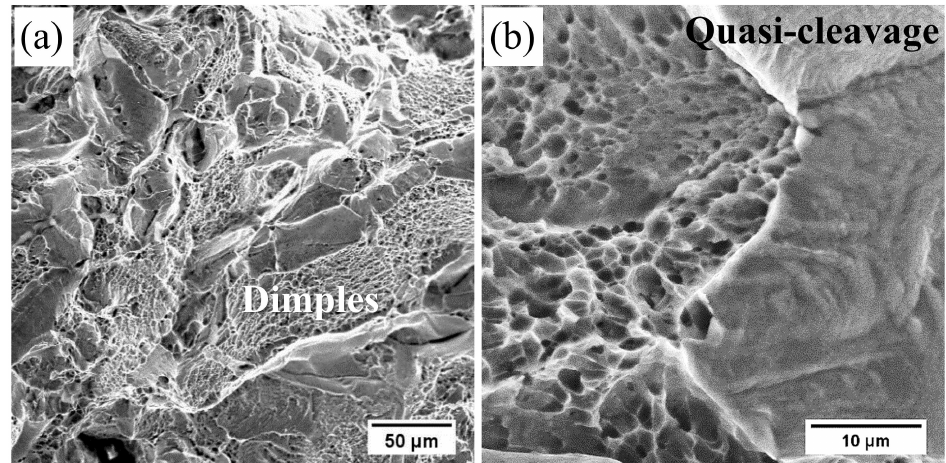
Figure 9. (a) and (b) Fracture surface of Ti-30Nb-3Fe alloy after aging at 500 ºC applying a heating rate of 1 ºC/min for 30 min.